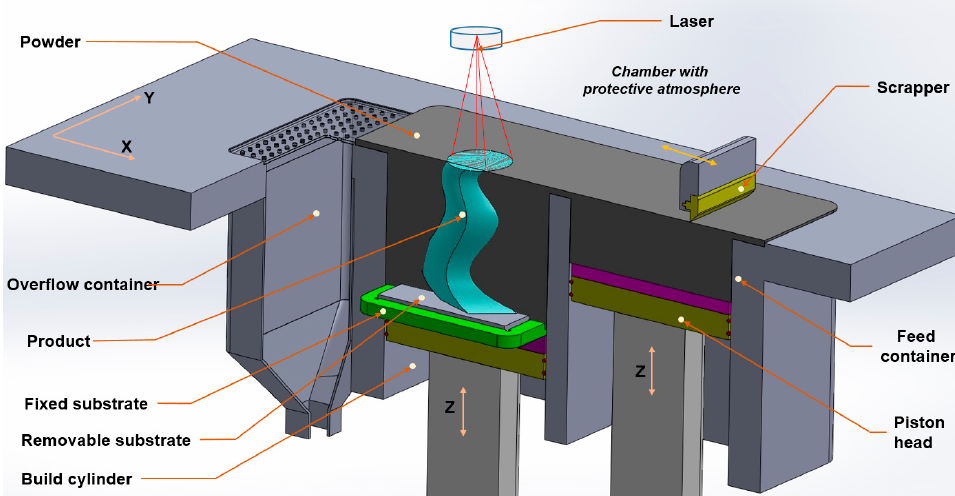
Figure 1. The selective laser melting (SLM) printing process [11].